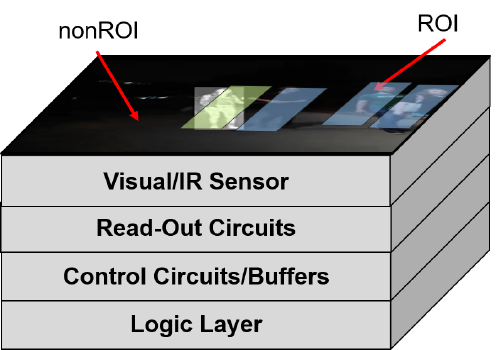
Figure 6. System architecture for the Feedback Imager. A 3D stacked topology allows for the ML control tier to be closely coupled with the sensor